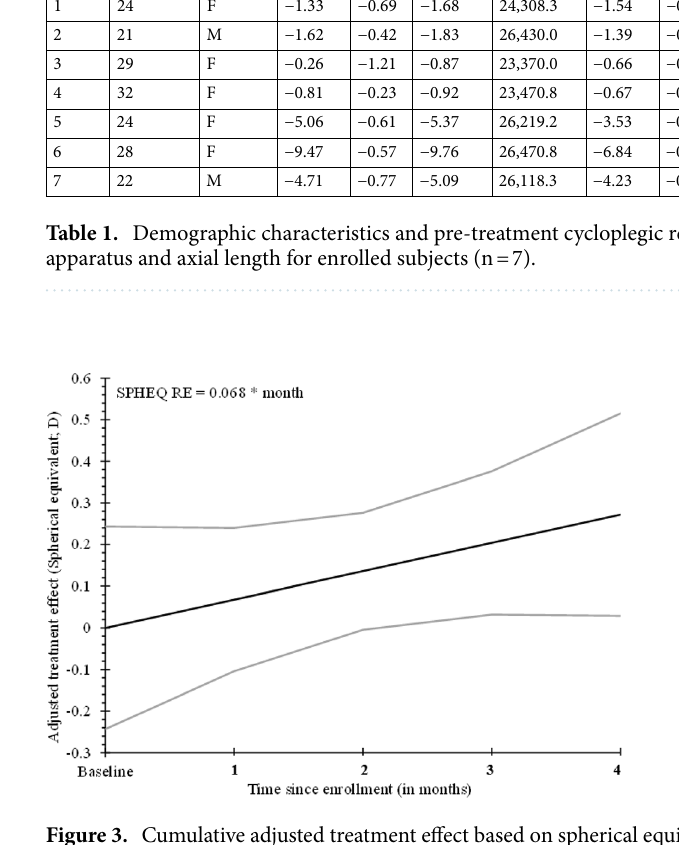
Figure 3. Cumulative adjusted treatment effect based on spherical equivalent refractive error ( D ) using WAM. Light grey lines represent the 95% confidence band around the regression